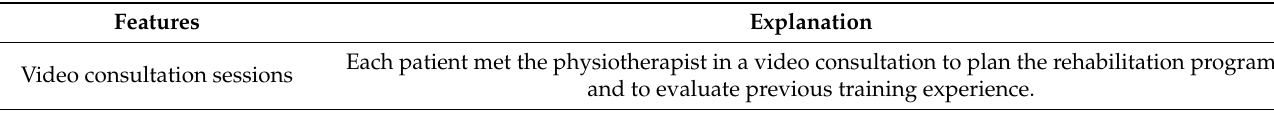
Table 1. The tele-rehabilitation program.